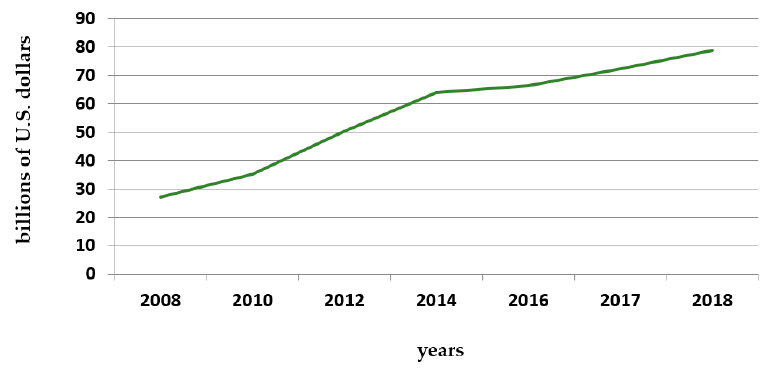
Figure 7. Global pharmaceutical revenue of anti-diabetic products in billions of U.S. dollars from 2008 to 2018. Source: Mikulic 2020—Statistics & Facts [105].